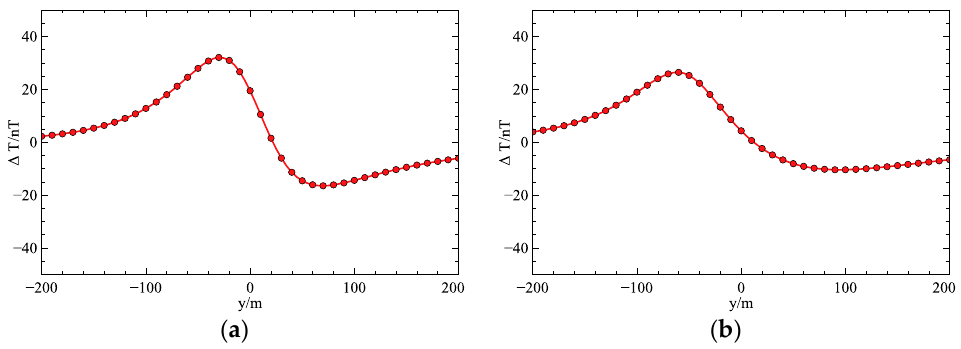
Figure 5. Anormal magnetic field ∆ T of Model 1 and 2. ( a ) Model 1, ( b ) Model 2.